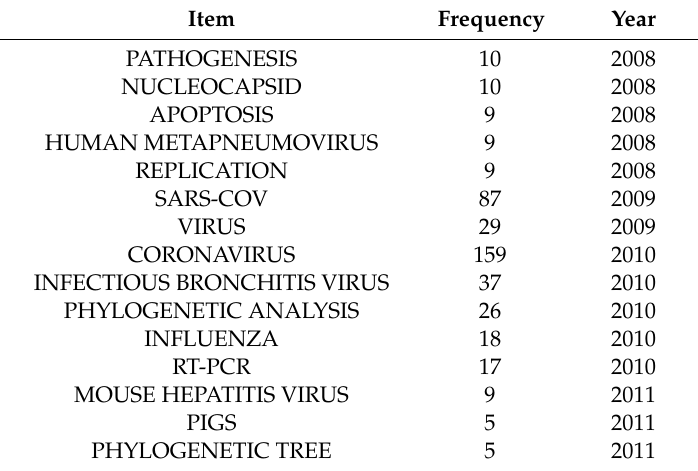
Table 6. Top cited papers with over 400 citations during 2008 – 2011.